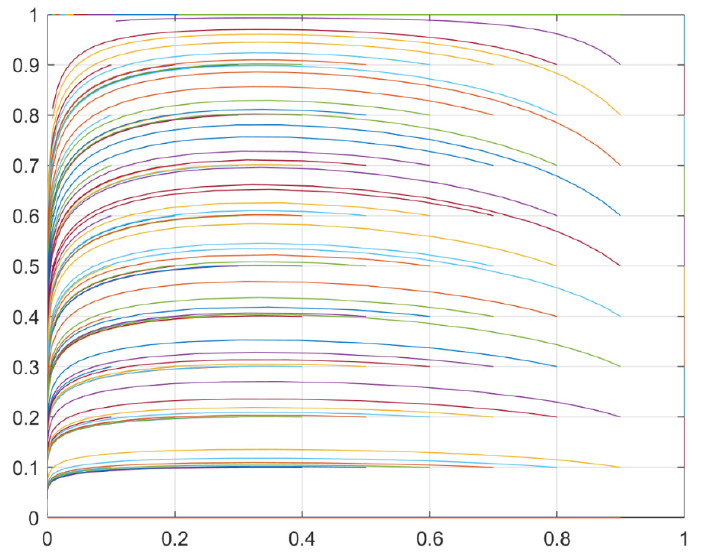
Figure 3. Dynamic evolution phase diagram for construction enterprises 1 and 2 in case (1) and (4).